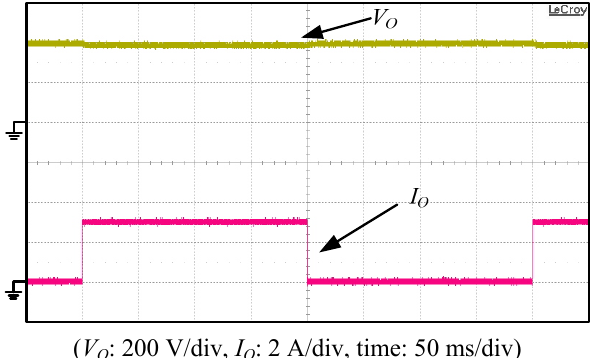
Figure 30. Output voltage V and 100% of the full load condition of the active clamp interleaved boost converter.